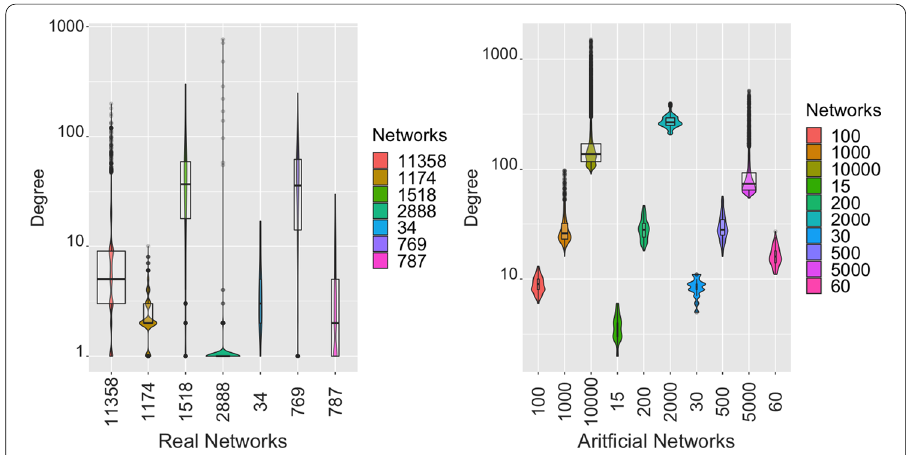
Fig. 4 The degree distribution of unweighted real networks is shown on the left and the degree distribution of unweighted artificial networks used in the simulation is shown on the